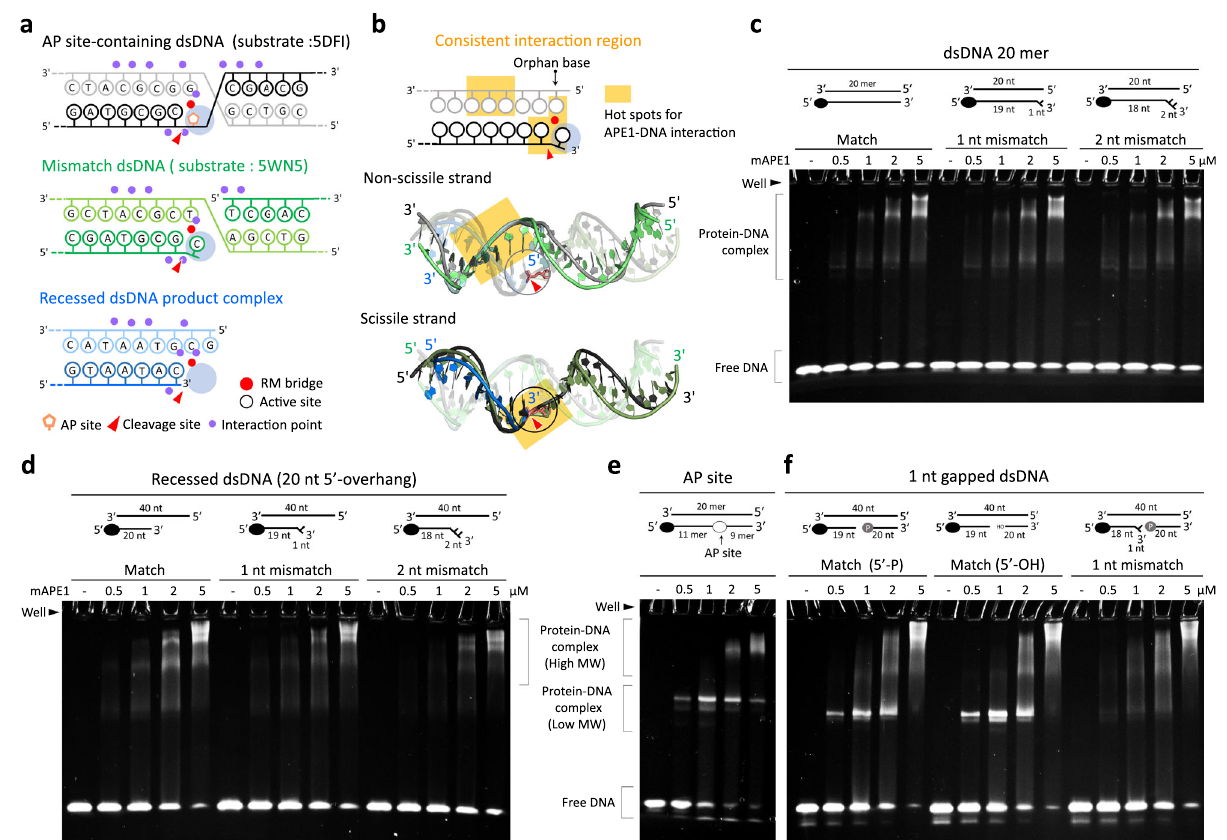
Fig. 6 Structural analysis and binding assay measurements of APE1 on various dsDNAs. a The comparison of protein – DNA interacting patterns in hAPE1 AP site-containing dsDNA complex (PDB entry: 5DFI), hAPE1-mismatched dsDNA substrate complex (PDB entry: 5WN5), and mAPE1-recessed dsDNA product complex. The interactions between APE1 and DNA are marked by purple balls. b Superposition of the dsDNAs in the aforementioned APE1 – dsDNA complexes. The consistent interaction region emerges in the overlay of these structures, yellow boxes. c – f EMSA measurements of full-length mAPE1 binding with a match or mismatched blunt-ended dsDNA, recessed dsDNA, AP site-containing dsDNA, and 1-nt gapped dsDNA. The band of protein – DNA complex with a lower molecular weight is speci fi cally observed in the binding with AP site-containing dsDNA and matched 1-nt gapped dsDNA. c – f Source data are provided as a Source Data fi